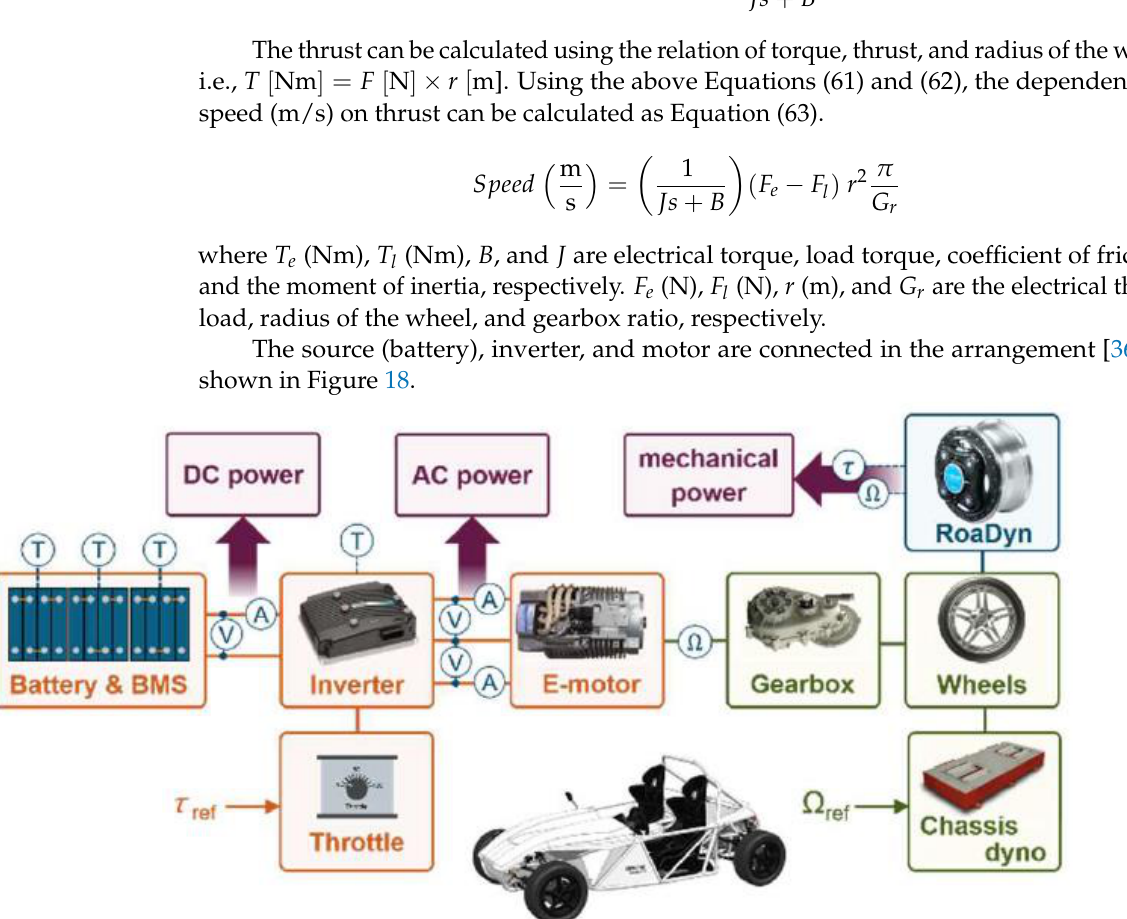
Figure 18. Instrumental powertrain schematic view.